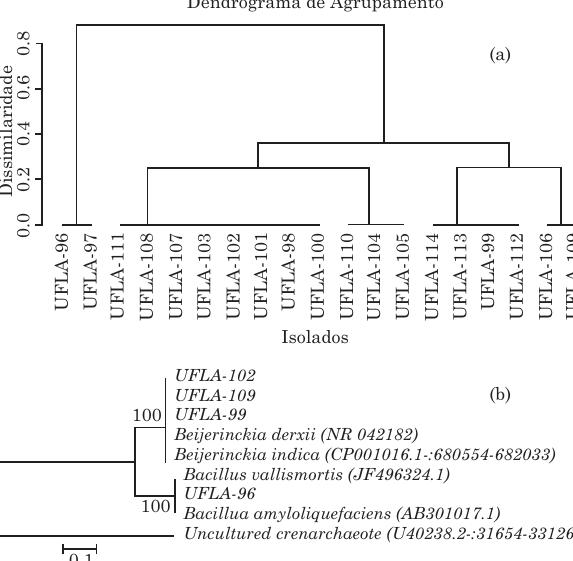
Figura 3. Dendrograma de agrupamento baseado nas características culturais dos 19 isolados de diazotróficas oriundos de solo sob seringal da UFLA, Lavras, MG (2009)(a), dendrograma mostrando as relações filogenéticas entre os